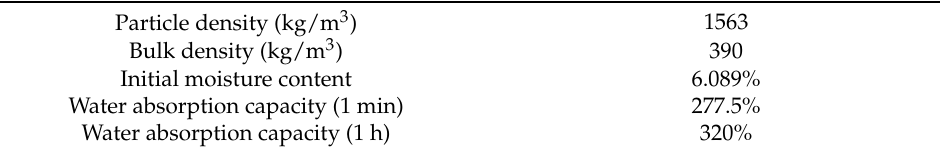
Figure 1. Recycled bamboo particle size distribution. Table 1. Characteristics of moso